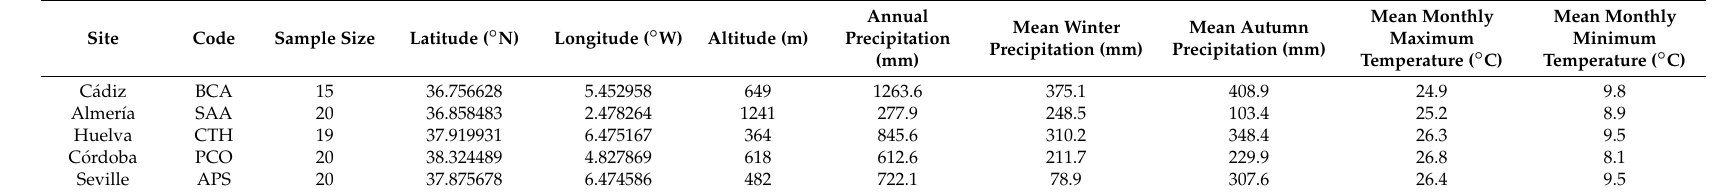
Table 1. Geographical and climatic data of the population of Quercus ilex subsp. ballota included in this